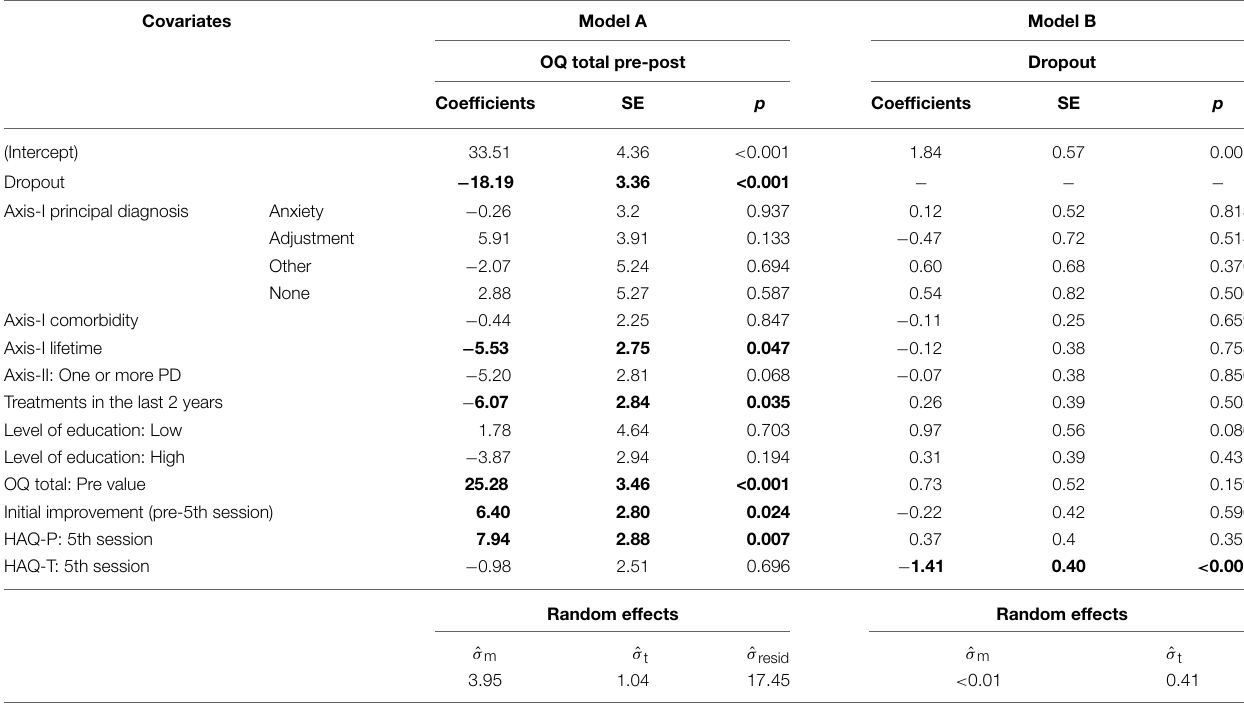
TABLE 3 | Mixed models for the prediction of the overall improvement (Gaussian) and of the propensity to drop out (binomial). Covariates Model A Model B OQ total pre-post